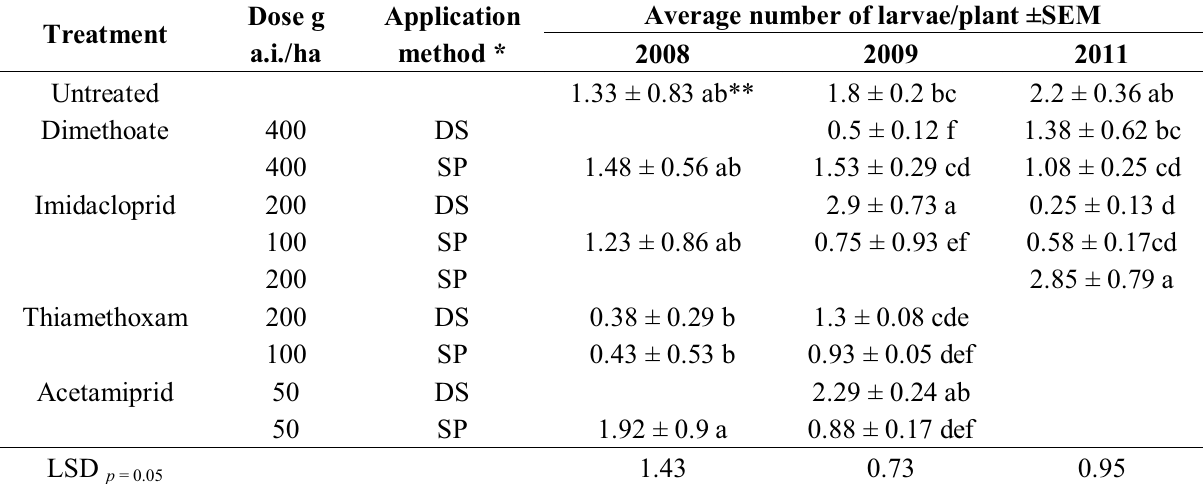
Table 8. Experimental results determined on the basis of dissection of plants and establishing average number of Delia radicum (L.) larvae/plant (±SEM) in three year trials with insecticides, or